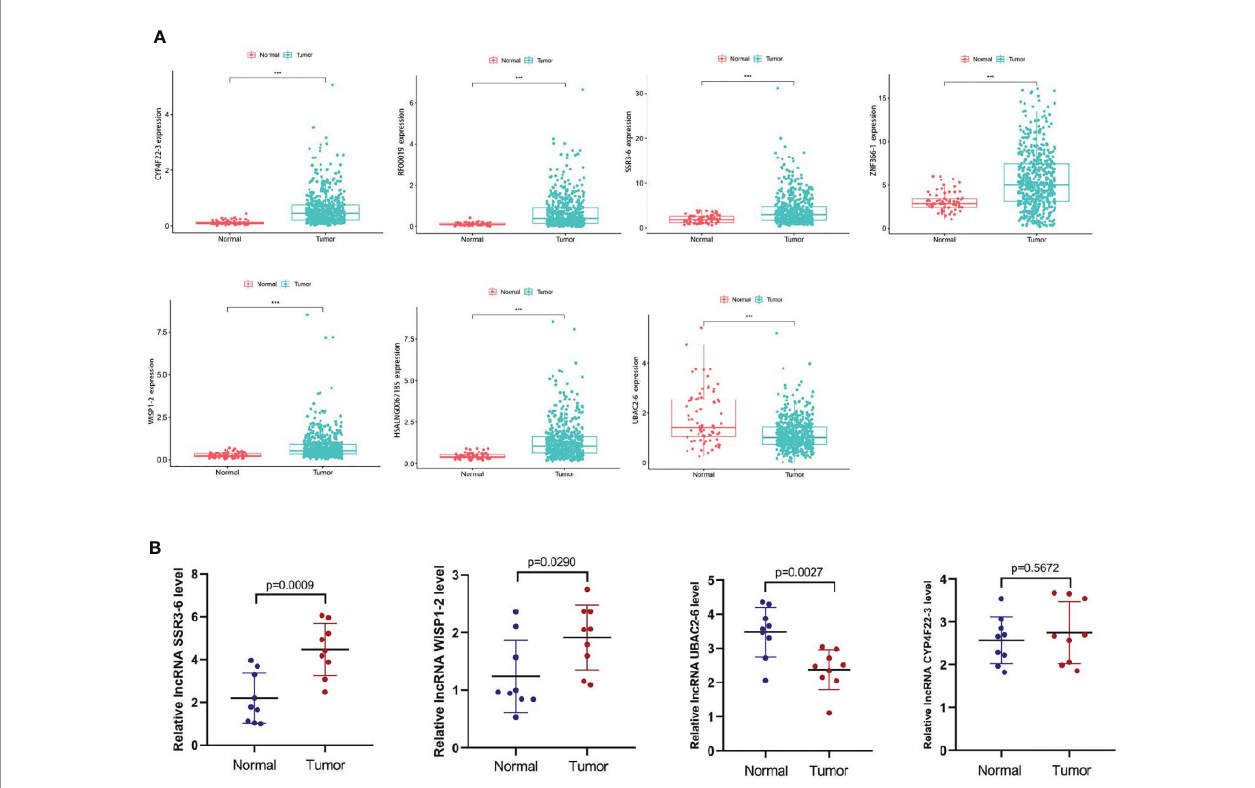
FIGURE 8 | Expression levels of the metastasis-related lncRNAs in ccRCC. (A) We predicted the expression levels of the 7 metastasis-related lncRNAs in TCGA database (normal=72, tumor=539). (B) We detected the expression levels of SSR3-6, WISP1-2, CYP4F22-3 and UBAC2-6 in carcinoma and adjacent tissues of ccRCC patients (normal=9, tumor=9). SSR3-6, WISP1-2 was highly expressed in carcinoma tissues, UBAC2-6 was highly expressed in adjacent